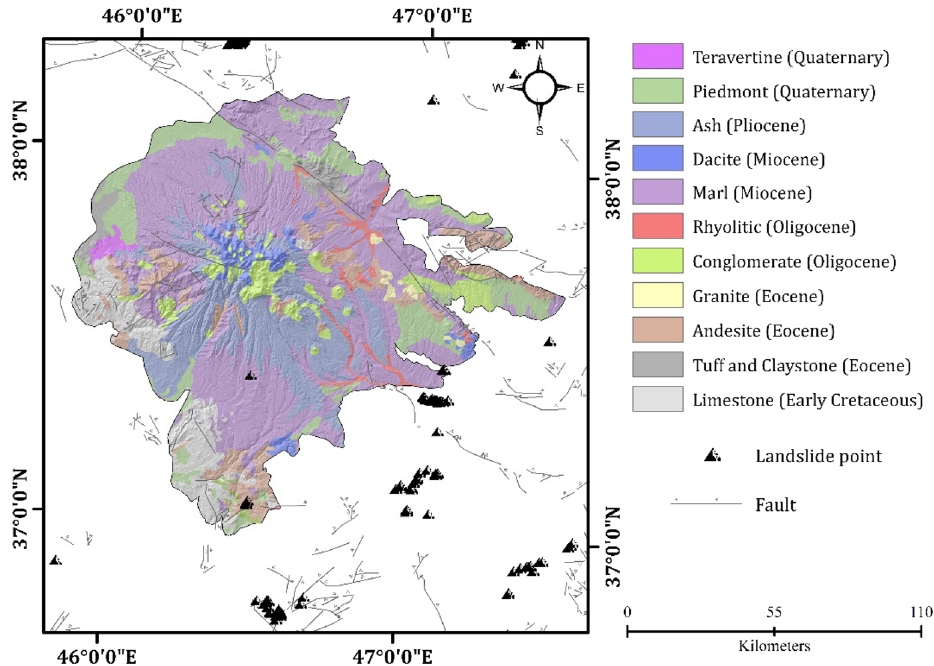
Figure 8. Geomorphological features of Sahand